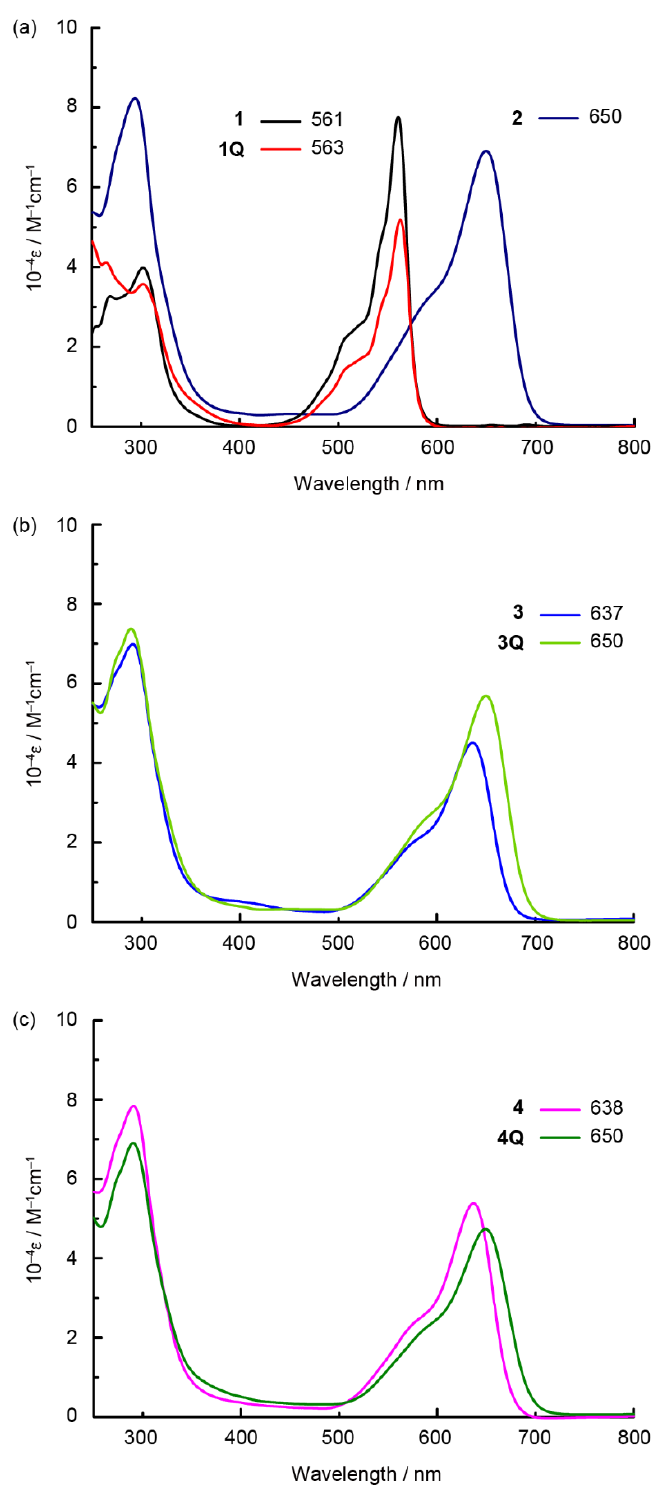
Figure 2. UV-vis-NIR absorption spectra of SubPcs in dichloromethane solutions. ( a ) 1 (black), 1Q (red), and 2 (purple); ( b ) 3 (blue), and 3Q (light green); ( c ) 4 (pink) and 4Q (green).